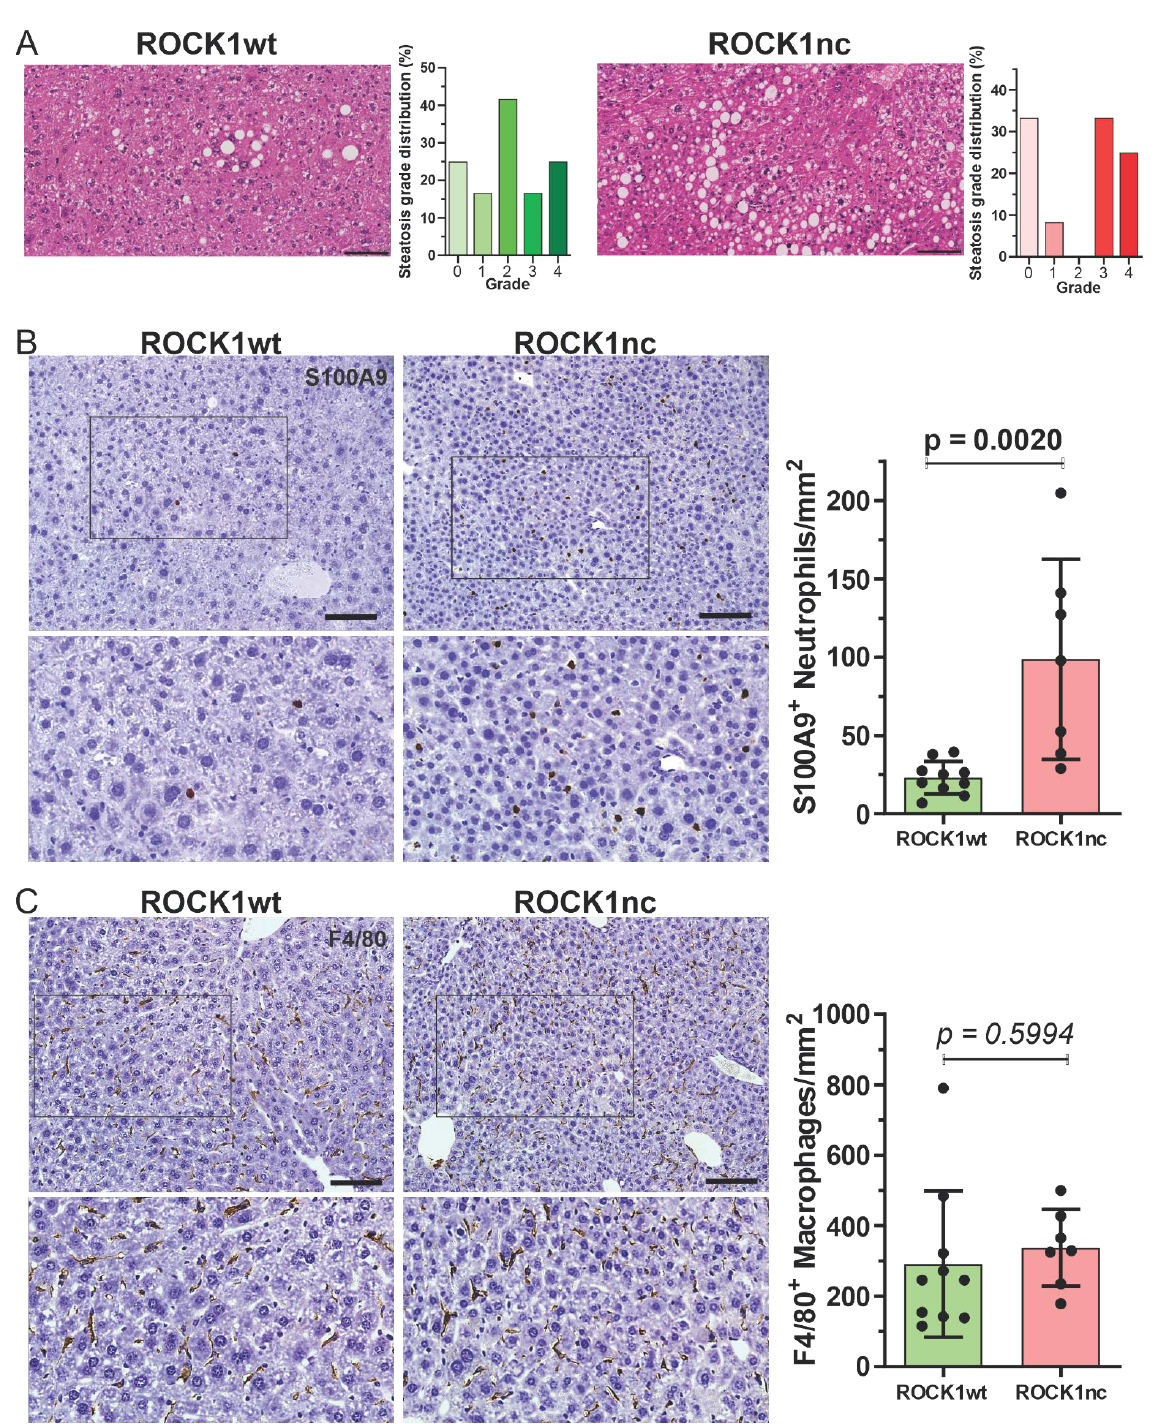
Figure 3. ROCK1nc liver tumours show greater steatosis and neutrophil numbers than ROCK1wt liver tumours. ( A ) H&E staining of representative liver tumour sections from ROCK1wt or ROCK1nc mice 9 months after DEN treatment. Steatosis was determined on H&E-stained sections as a percentage of the total area from 10 random fields per section per mouse, and graded according to the following criteria: grade 0, <5%; grade 1, 5 – 25%; grade 2, 26 – 50%; grade 3, 51 – 75%; grade 4, >75%. Scale bars = 100 µm. The example ROCK1wt field was grade 2, and the ROCK1nc field was grade 4. ( B ) Representative Immunohistochemical (IHC) images of anti-S100A9 antibody-stained formalin-fixed paraffin embedded (FFPE) liver sections showing neutrophils (brown) in liver tumours (left panels), and corresponding bar graph (right panel). S100A9 positive neutrophils were scored